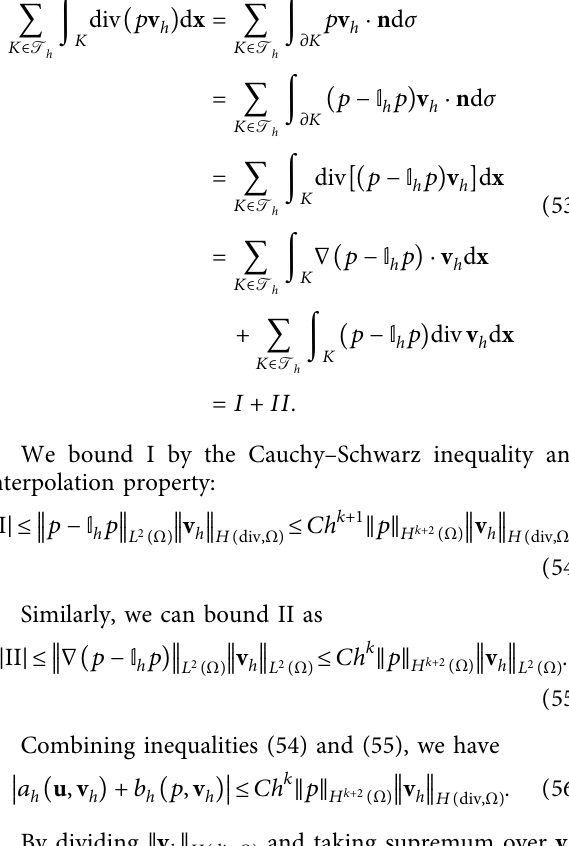
Figure 2: Subregions Ω i,b and Ω i,t , i � 1 , 2 , 3 ,